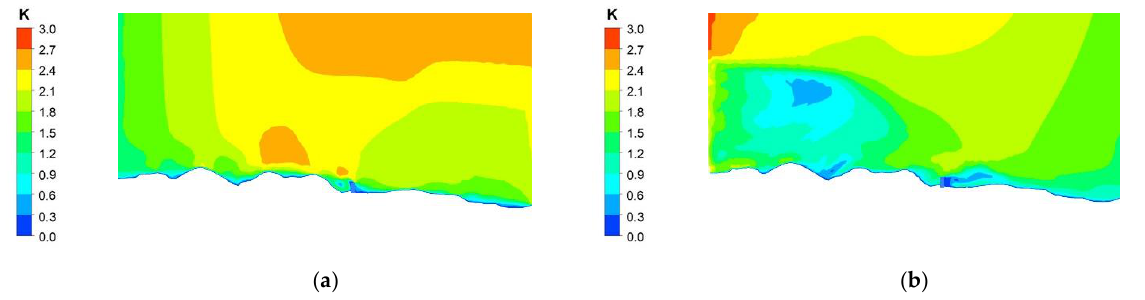
Figure 12. Normalized mean wind speed around the shelterbelt over complex terrain ( a ) Northeast direction; ( b ) southwest direction.